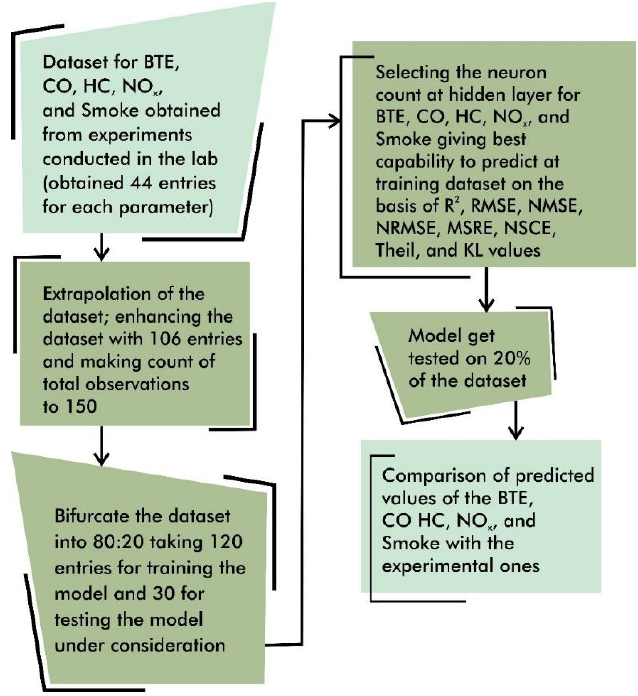
Figure 3. Steps followed for deploying ANN based